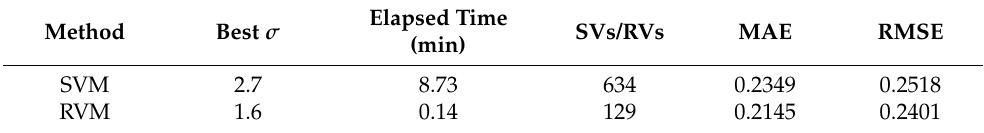
Table 2. Comparison of SVM and RVM